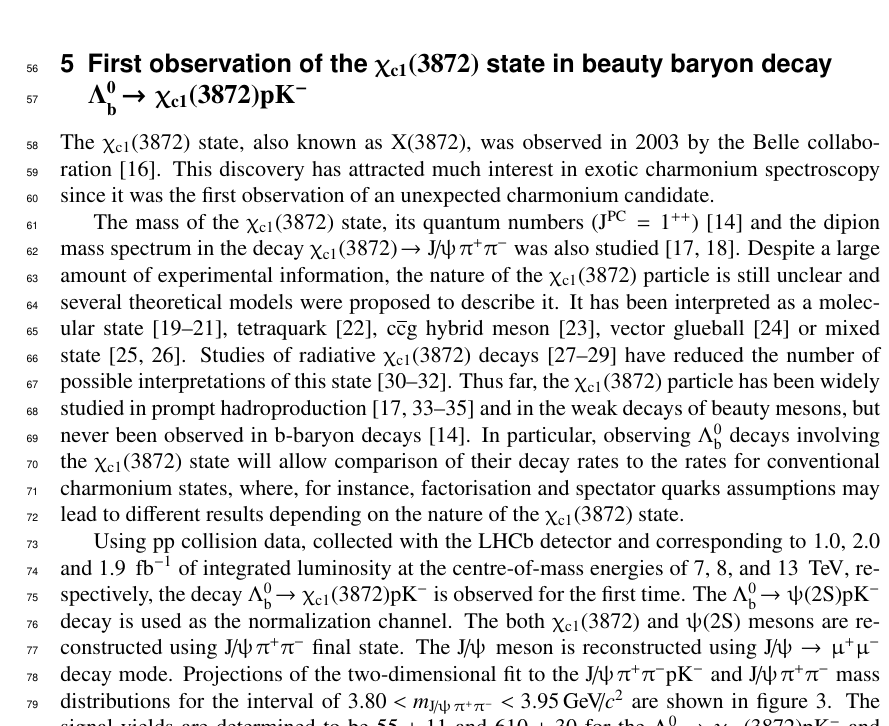
Figure 2. Mass distributions of the (left) Λ 0 ψ (2S)pK − scale) Λ 0 b →